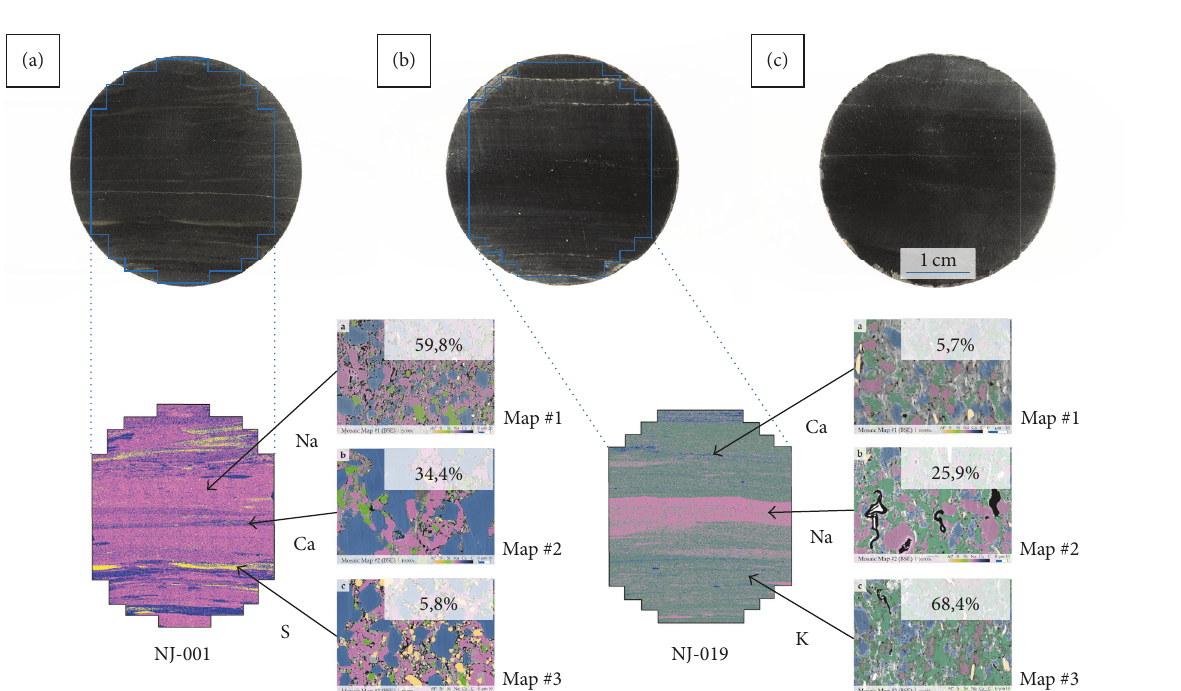
Figure 8: Photographs of all three samples (top) plus distinct layers based on EDX analysis (bottom) and their respective area fractions of the plug surface for sample NJ-001 and NJ-019.